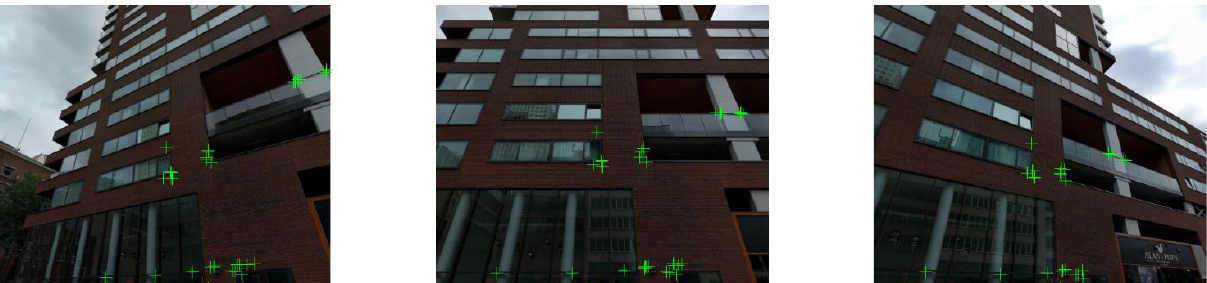
Figure 4. Image matching result of image triplet. From left to right: 60, 90, and 120 degrees perspective